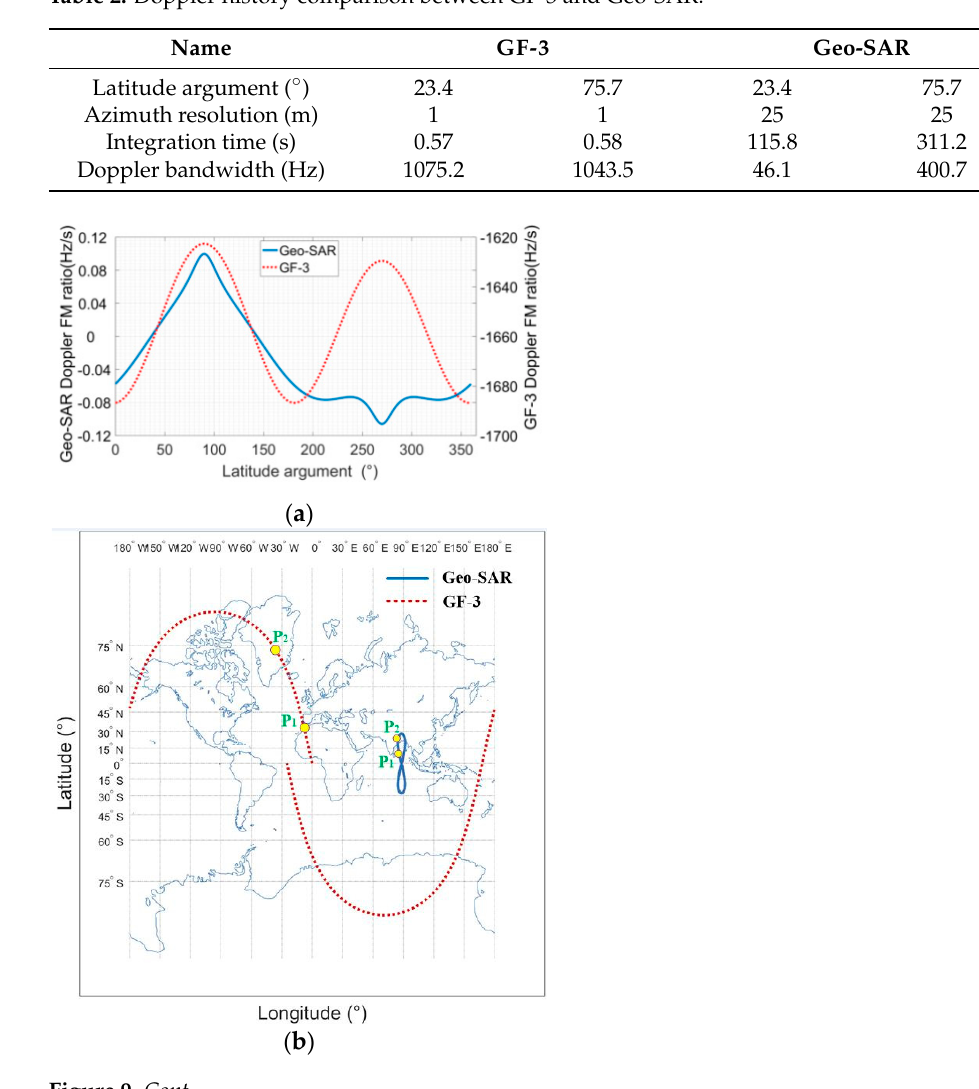
Table 2. Doppler history comparison between GF-3 and Geo-SAR.